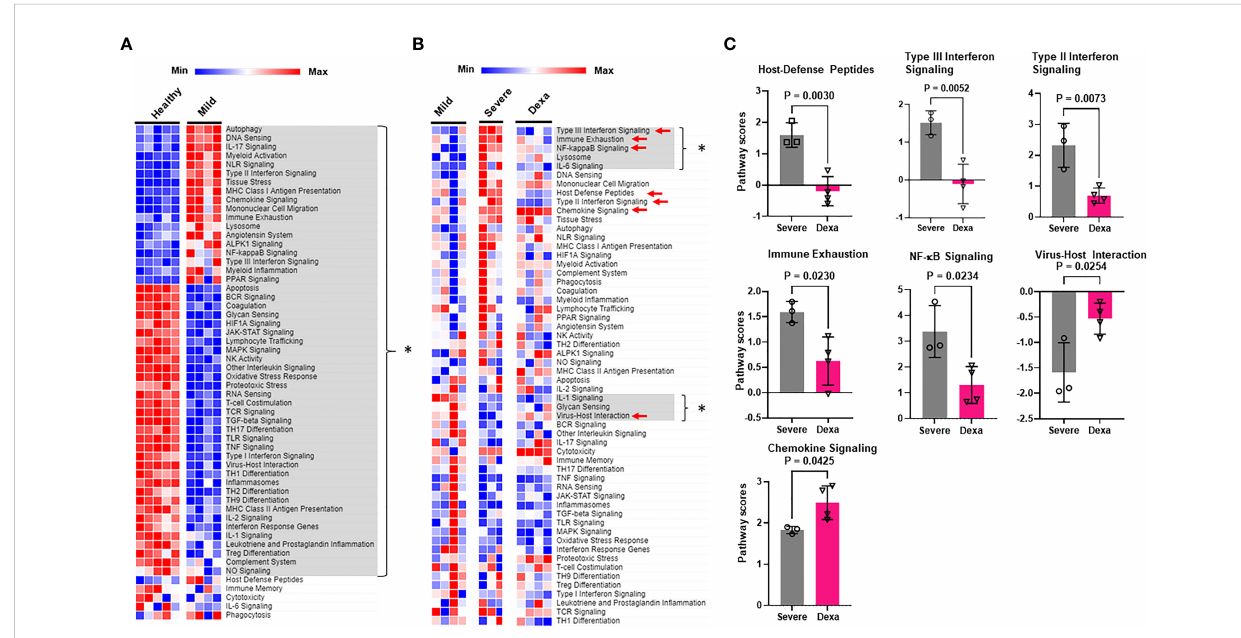
FIGURE 2 Immune signaling pathways altered by COVID-19 and by dexamethasone. (A) Heatmap depicting immune signaling pathway scores in PBMCs from healthy donors (n=5) and COVID-19 patients with mild disease (n=4). Signi fi cantly altered pathways are highlighted in gray and represented by * (B) Heatmap depicting immune signaling pathway scores in PBMCs from patients with mild (n=4), severe COVID-19 (Severe, n=3), and severe COVID-19 + dexamethasone (Dexa, n=4). Signi fi cantly altered pathways between mild and severe groups are highlighted in gray and represented by *, and those altered between severe +/- dexamethasone are marked by red arrows. (C) Pathways signi fi cantly altered by dexamethasone treatment in severe COVID-19 patients. Bars represent means ± SD, and each symbol represents an individual. Signi fi cance determined by unpaired